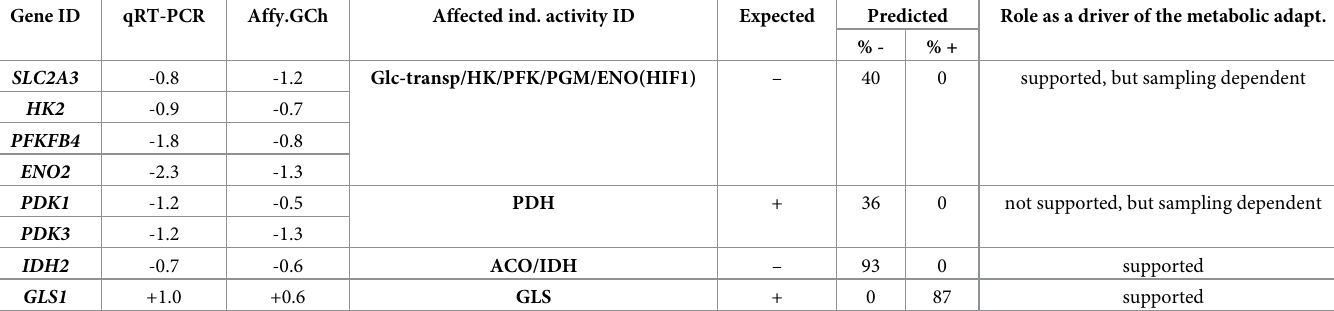
Table 2. Decreases/increases expected from measured genes differentially expressed and decreases/increases predicted in the metabolic activities affected by their encoded